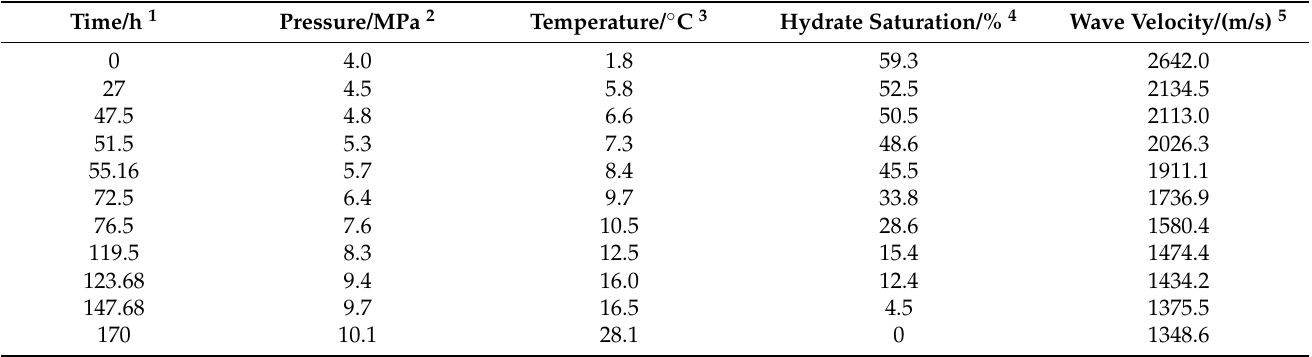
Table 2. Variations in pressure, temperature, hydrate saturation ( S h ), and wave velocity during hydrate dissociation (selected